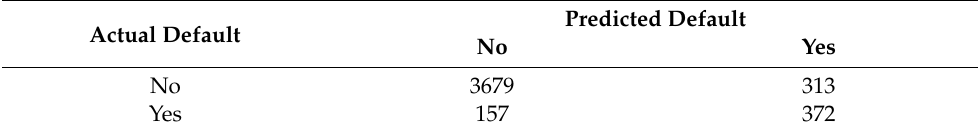
Table 7. Confusion matrix with C5.0 model and added cost matrix.